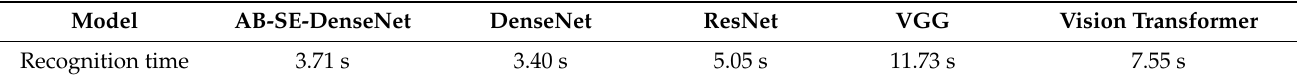
Table 6. Comparison of recognition time of different